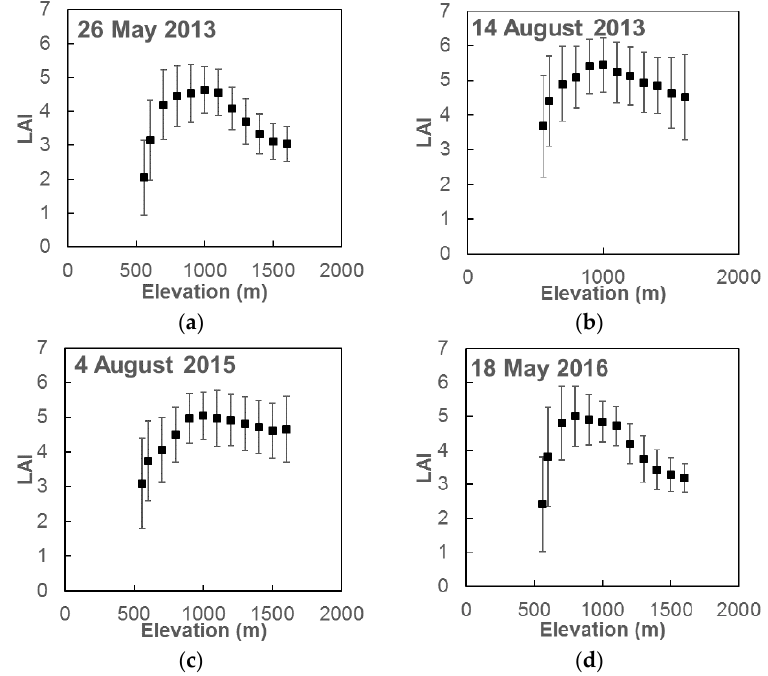
Figure 8. Spatial average LAI of DBF area for each 100-m altitudinal zone based on Landsat OLI sub-images dated 26 May 2013 ( a ); 14 August 2013 ( b ); 4 August 2015 ( c ); and 18 May 2016 ( d ) over the Daihachiga river basin. Error bars represent standard deviations.